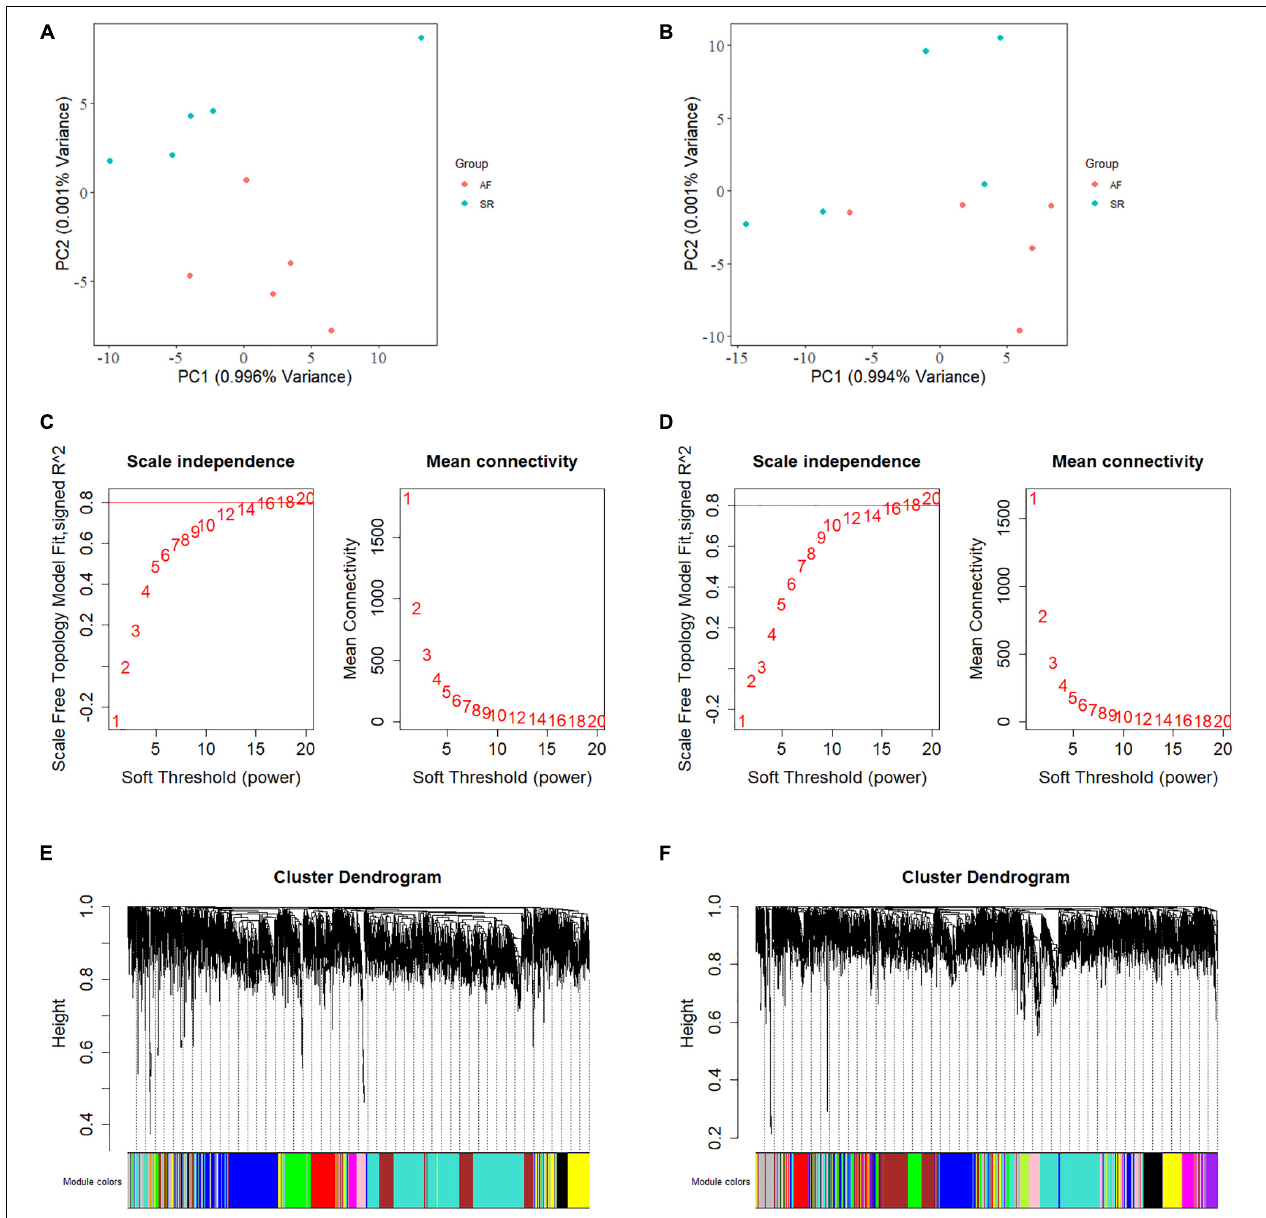
FIGURE 2 | The principal component analysis, the calculation of power indexes, and the generation of module cluster trees on expression data sets. (A) The PCA plot is shown for determination of outlier samples in LAA. (B) The PCA plot is shown for determination of outlier samples in RAA. (C) Analysis of network topology for various soft-thresholding powers in LAA. The y -axis of the left panel represents the scale-free fit index while the x -axis indicates the soft-thresholding power. The y -axis of the right panel displays the mean connectivity and the x -axis also represents the soft-thresholding power. (D) Analysis of network topology for various soft-thresholding powers in RAA. (E) The construction of module cluster tree in LAA. In the picture, branches correspond to the coexpression modules with highly interconnected groups of genes. (F) The construction of module cluster tree in RAA. LAA, left atrial appendage; PCA, principal component analysis; RAA, right atrial